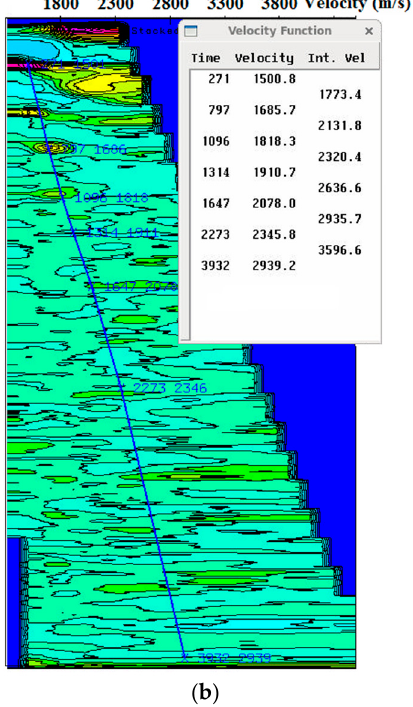
Figure 6. Seismic profiles obtained in shallow water north of the South China Sea. ( a ) Seismic profile; ( b ) Velocity spectrum.